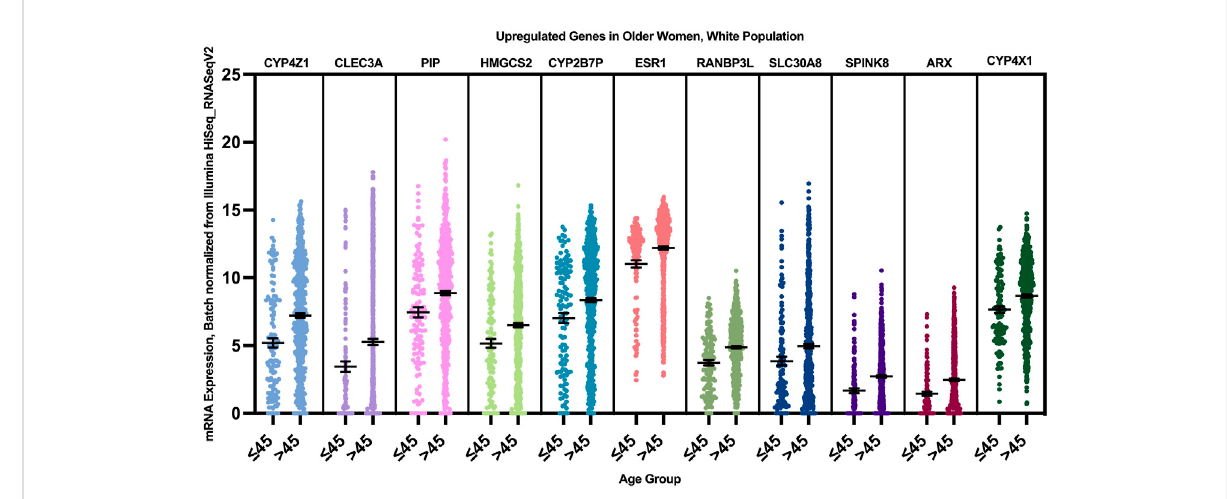
FIGURE 11 DifferentiallyexpressedgenesinolderandyoungpatientsoftheAsianpopulation( p < 0.005,student ’ st-test).ErrorbarsrepresentMean±SEM.